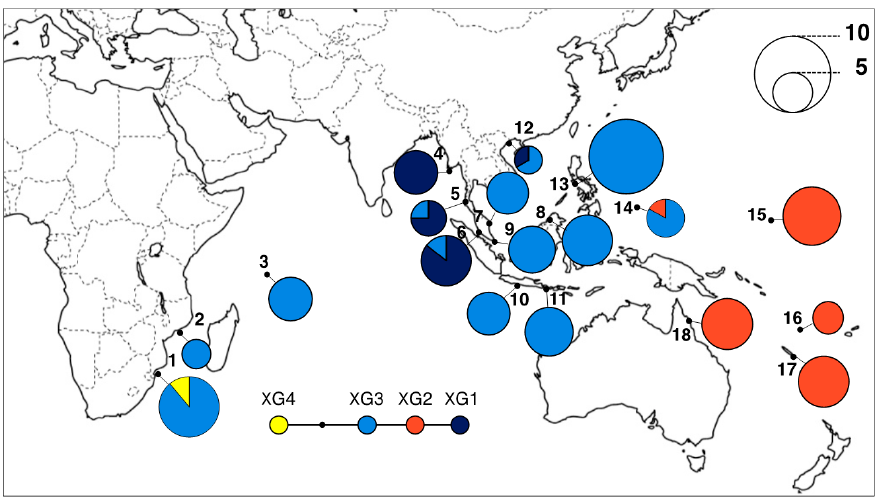
Figure 1. Geographical distributions of the four chloroplast (cp) DNA haplotypes of Xylocarpus granatum J. Koenig. The size of the pie charts indicates the sample size of the population. Population ID are defined in Table 1. The inset (bottom) denotes the haplotype network of the four haplotypes extracted from Figure 2.